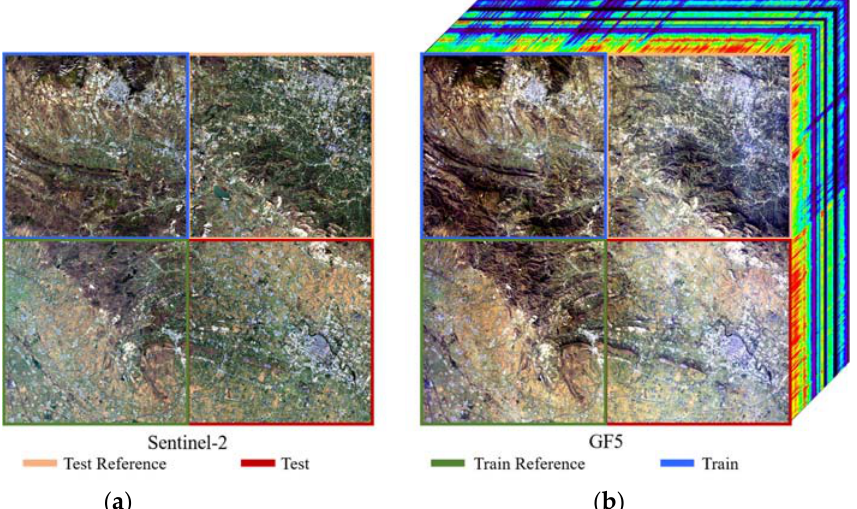
Figure 6. Illustration of Sentinel-2 and GF5 data sets, ( a ) is the Sentinel-2 dataset, ( b ) is the GF-5 dataset.